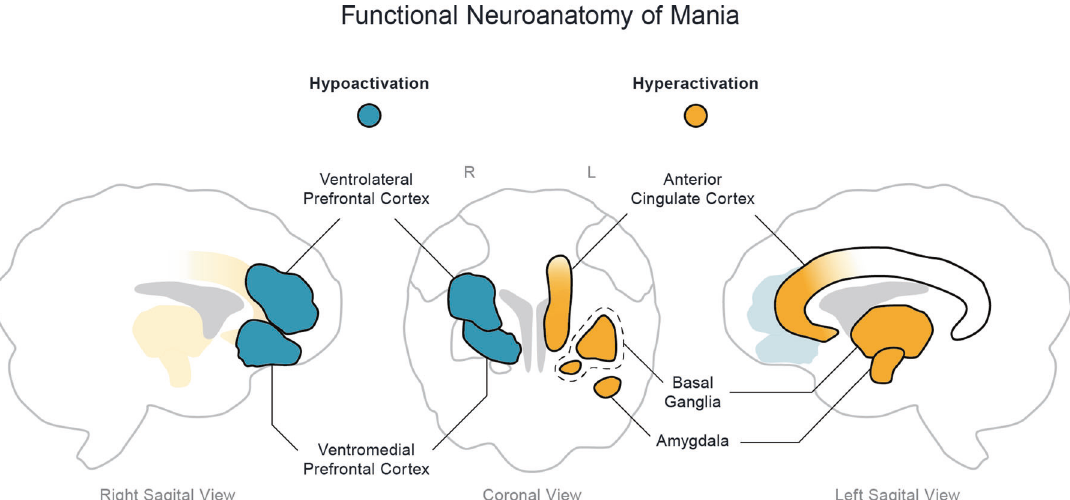
Fig. 2 Functional neuroanatomy of mania. Evidence from different functional neuroimaging studies suggest that there is a reduced activity of right ventromedial and ventrolateral prefrontal cortices and an increased activity of left amygdala, left anterior cingulate cortex, and left basal ganglia in